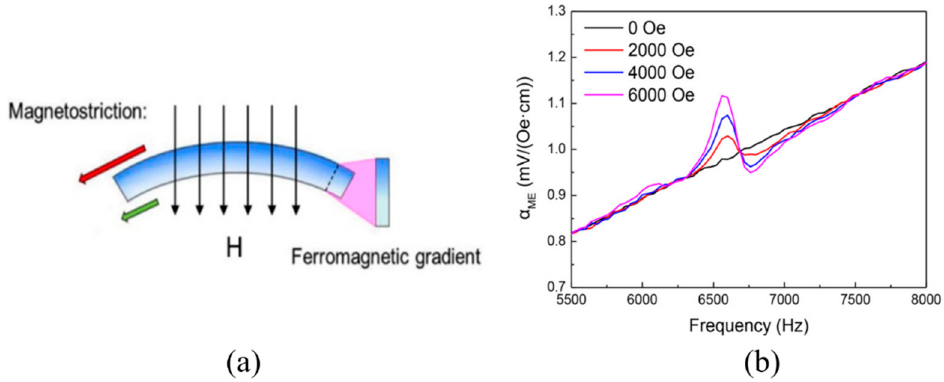
Figure 29. ( a ) A schematic illustration of the magnetic field-induced bending of the inhomogeneously reduced BFO-BTO ceramic wafers due to the inhomogeneous magnetostrictive response across the thickness. The bending causes a flexoelectric response. ( b ) The effect of the DC magnetic field on the magnetoelectric coupling coefficient for the BFO-BTO ceramics. The electric voltage is from the flexoelectric response. Reprinted with permission from [62]. Copyright 2019 Elsevier.